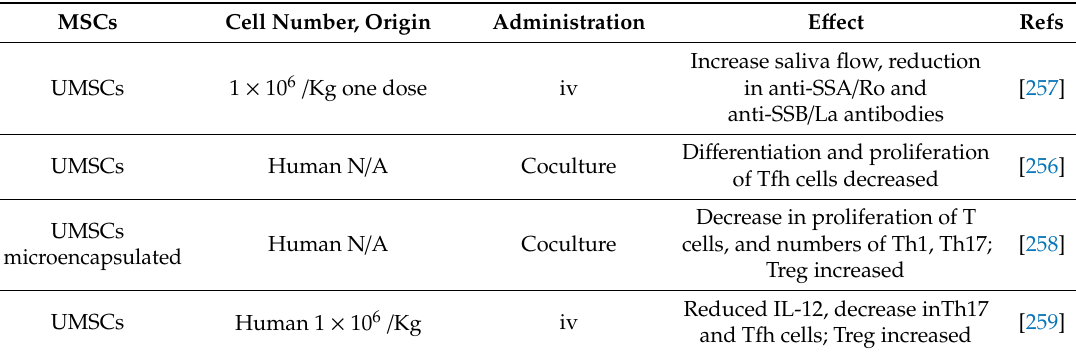
Table 3. Stem cells targeted therapies in pSS